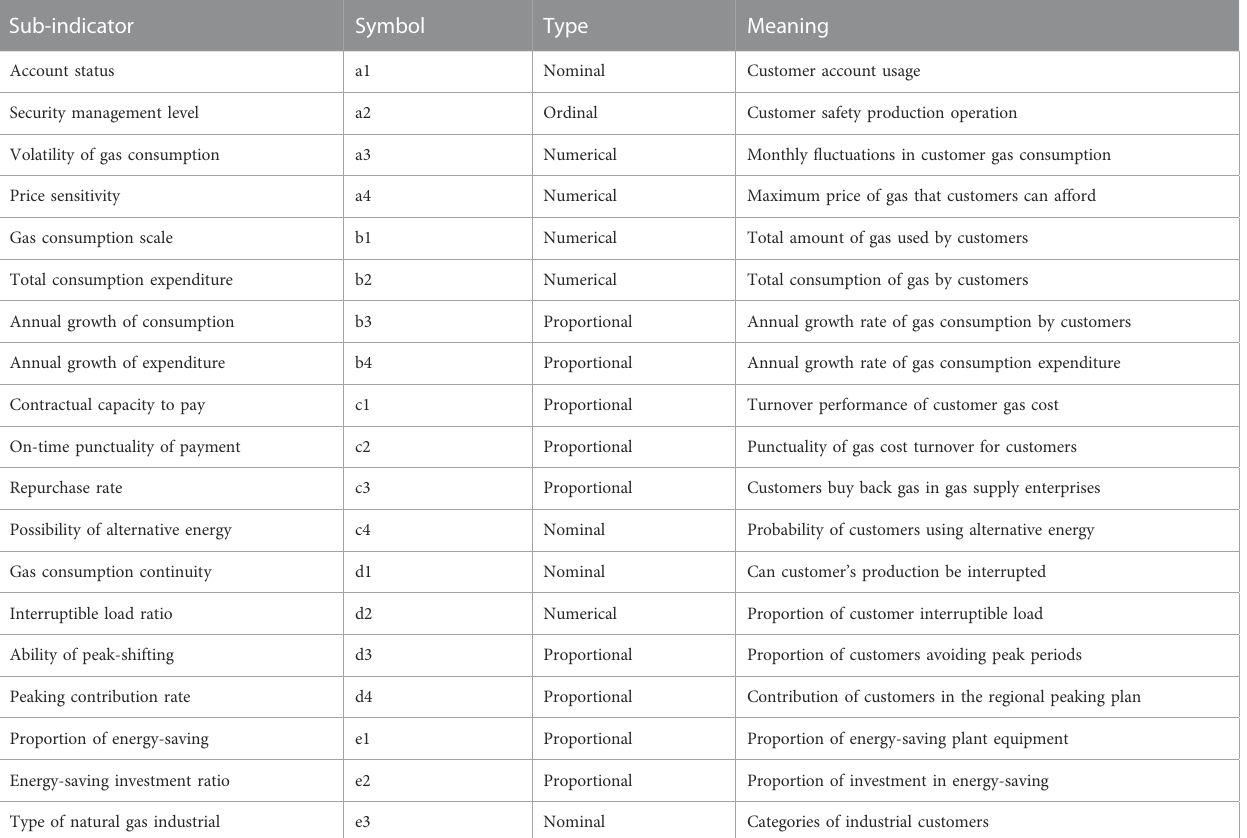
TABLE 1 Meaning of